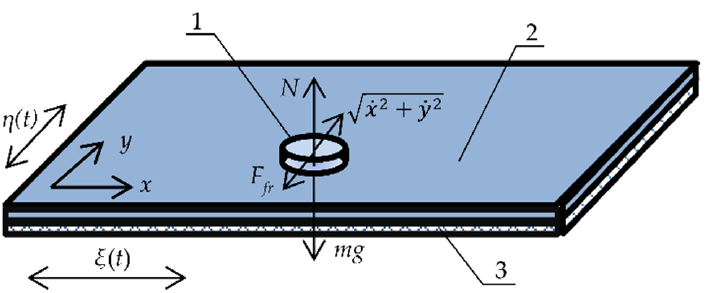
Figure 1. Dynamic model of nonprehensile manipulation on a circularly oscillating platform with dry friction control: (1) part; (2) platform; (3) piezoelectric actuator. The manipulation system consists of a horizontal platform excited in two perpendicu- lar directions by harmonic excitation with a phase shift: